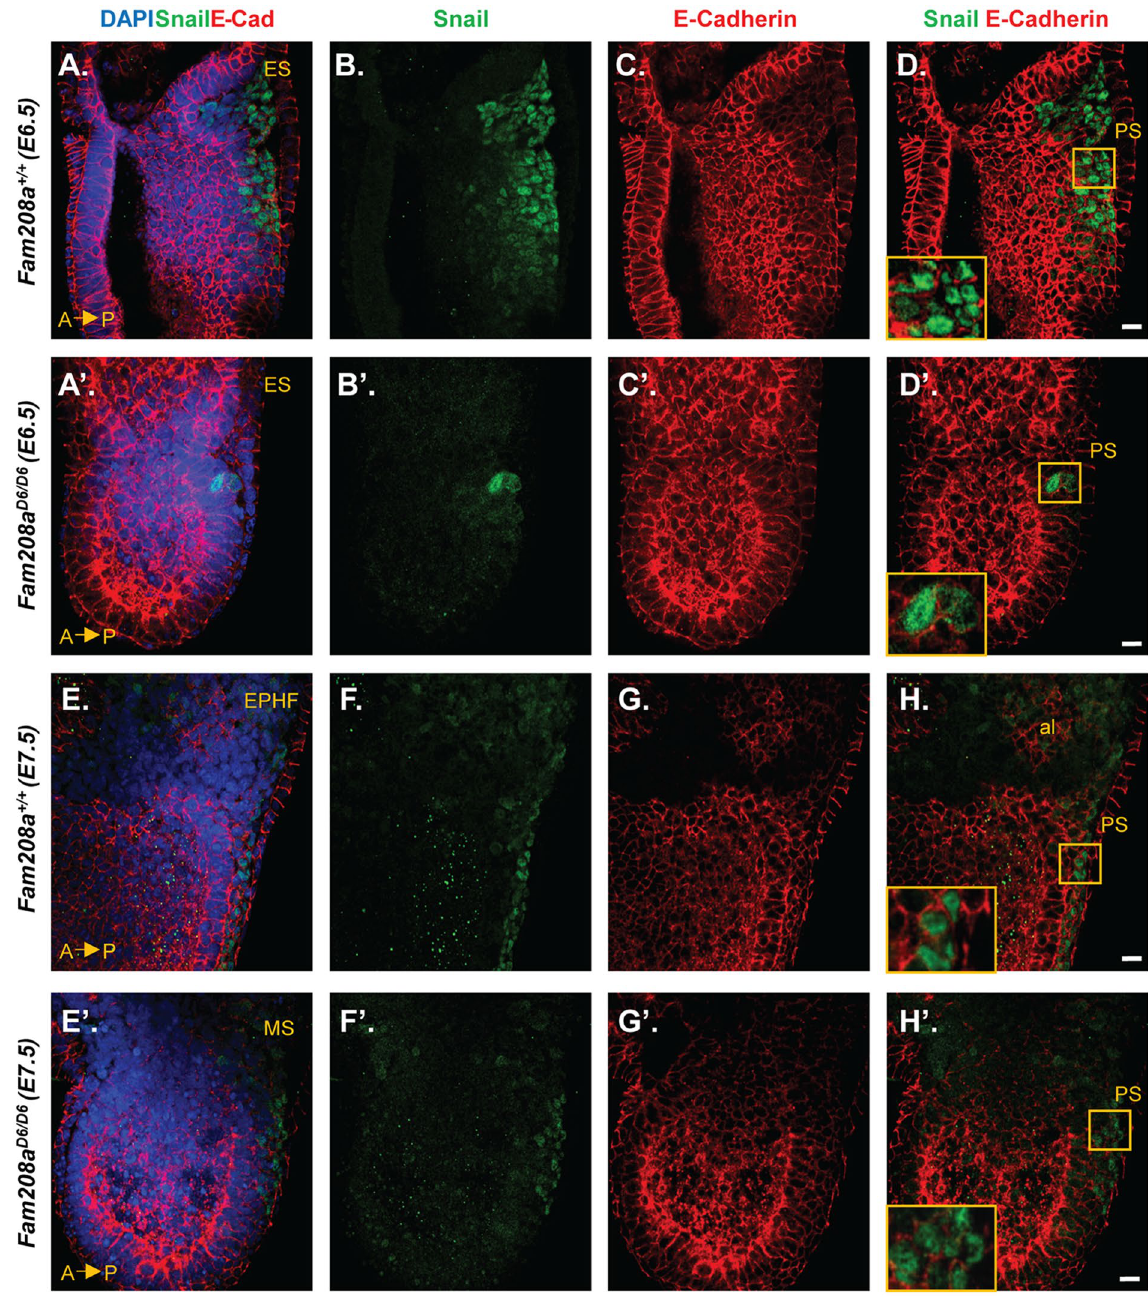
Figure 2. Fam208a D6/D6 mutants exhibit significantly delayed epithelial-to-mesenchymal transition during gastrulation. Whole mount immunofluorescence of mutant Fam208a D6/D6 embryos (E6.5: A’–D’ and E7.5: E’– H’ ) and their wildtype littermates (E6.5: A–D and E7.5: E–H ). ( D’ ) Confocal images show only a very few Snail- expressing (mesodermal marker, green) cells within the PS with failure to down-regulate E-cadherin (epiblast and endodermal marker, red) at E6.5. Snail expression increases along the elongated PS by E7.5 but gets arrested halfway. The boxed region to the bottom left is of 4-fold magnification. Scale bar: 30 µ m. ES, Early streak; EPHF, Early pre-head fold; MS, Mid-streak; PS, Primitive streak; Al,